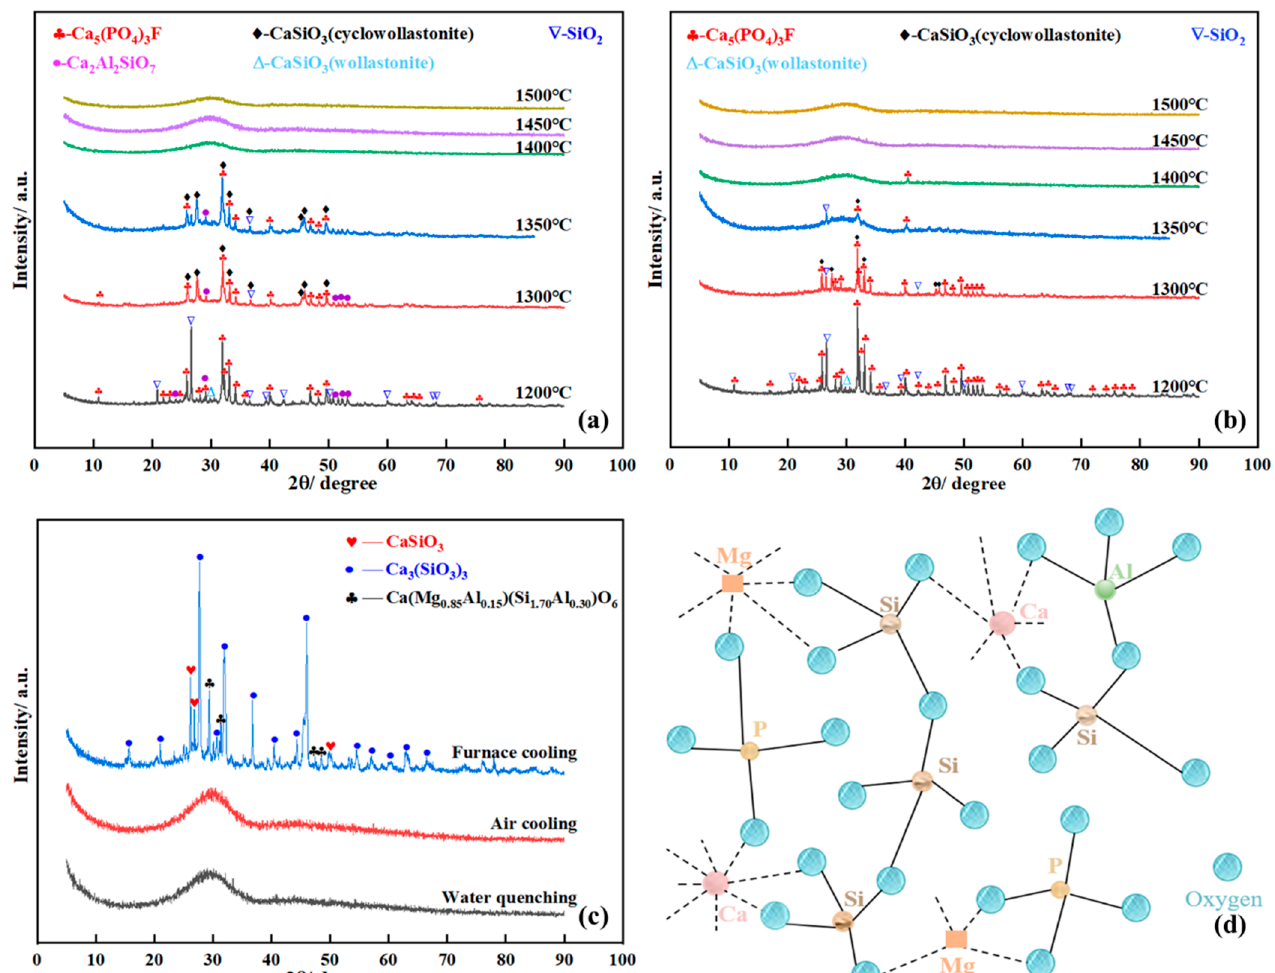
Figure 5. Effect of cooling regimes on the phase transformation of the mixtures with an acidity of 0.92 smelted at different temperatures for 60 min in pure N 2 (99.99%) atmosphere. ( a ) Air cooling; ( b ) Water quenching; ( c ) Phase comparison of the mixture smelted at 1450 °C for 60 min under different cooling regimes; ( d ) Glass structure of YPS after water quenching.